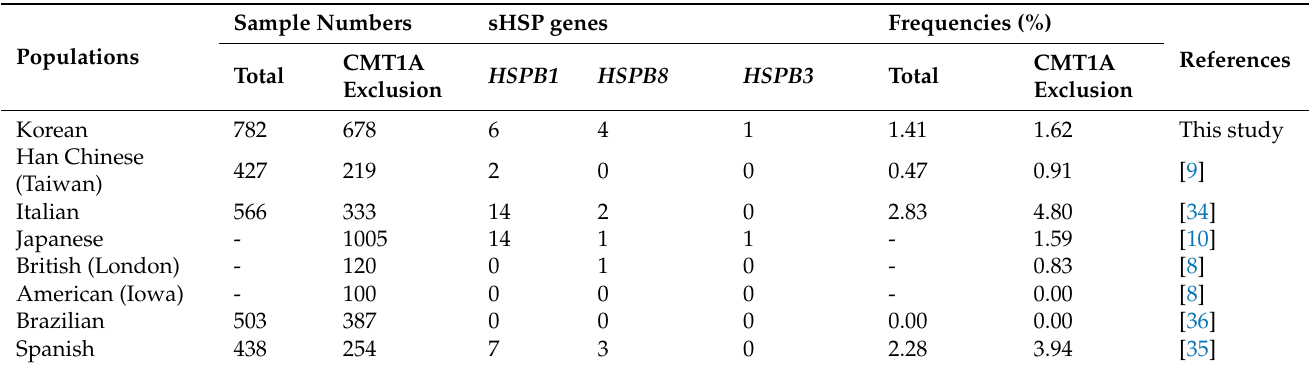
Table 2. Frequencies of inherited peripheral neuropathy patients with small heat shock protein gene mutations according to